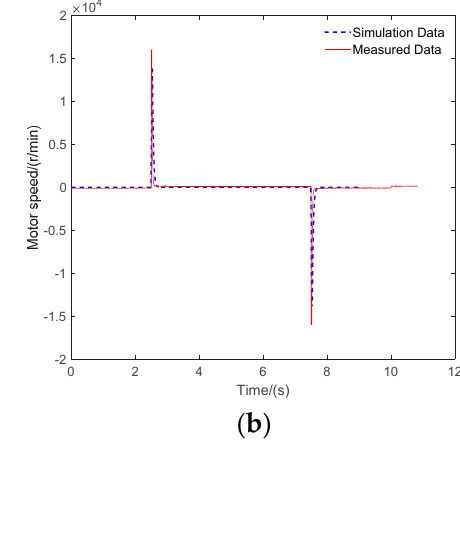
Figure 9. Comparison between Euler simulation results and measured data. The five state variables of displacement, speed, q axis current, d axis current, and pressure difference between the left and right chambers of the hydraulic cylinder are integrated and calculated respectively, and the iterative calculation is carried out contin- uously according to the displacement command. Finally, all the calculated points of the five state quantities at each time are compared with the measured signals, as shown in Figures 10 and 11.